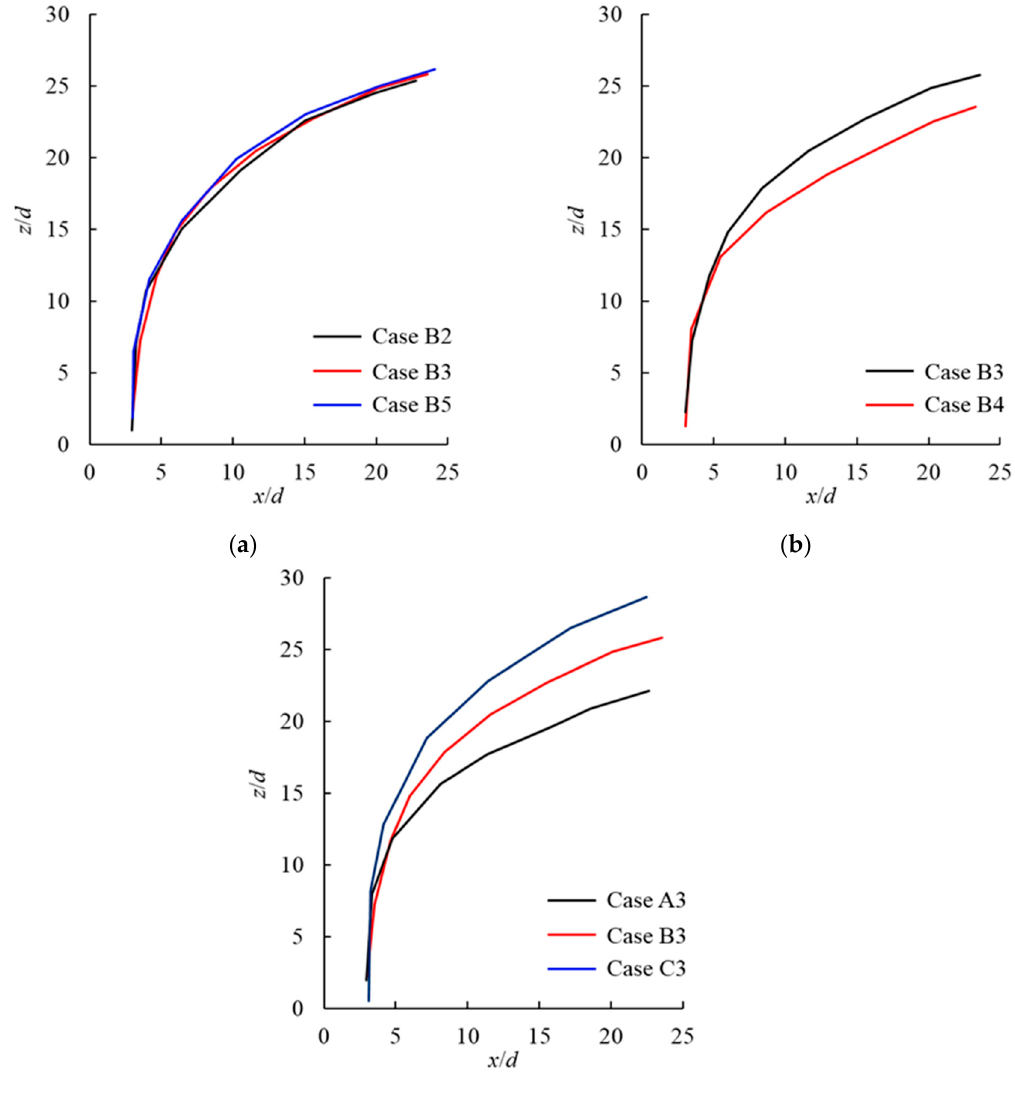
Figure 10. Effects of dimensionless parameters on the trajectories of twin buoyant jets in the wave and current environment: ( a ) effect of St ; ( b ) effect of R wc ; ( c ) effect of R jc . Then, the variable on each axis in Figure 10 is multiplied by the dimensionless parameter d / l mb